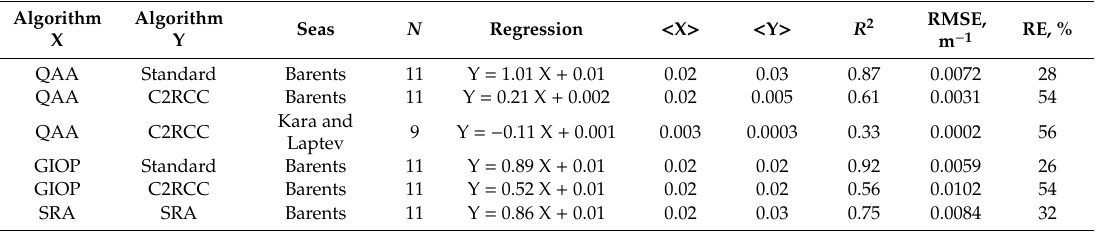
Figure 13. Scatterplots of in situ b bp (555) data and data from satellite calculations for the Barents Sea ( a ), the Kara Sea, and the Laptev Sea ( b ). Red circles — RSA algorithm for the Level 2 data, red crosses — RSA_C2RCC algorithm; blue circles — QAA algorithm for the Level 2 data, blue crosses — QAA_C2RCC algorithm; green circles — GIOP algorithm for the Level 2 data, green crosses — GIOP _C2RCC algorithm; yellow circles — SRA. Dashed lines — 1: 1 match. Table 7. Regression parameters between b bp (555) from satellite (Y) and in situ (X) data for di ff erent algorithms (only cases where the values of the coe ffi cient of determination exceed 0.3).